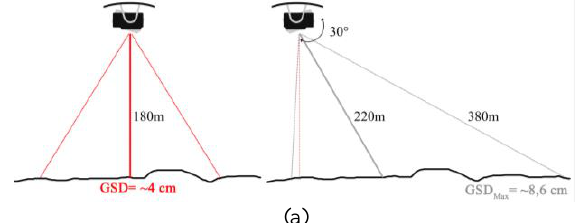
Figure 5. The estimation of average GSD on the nadir and oblique camera pose